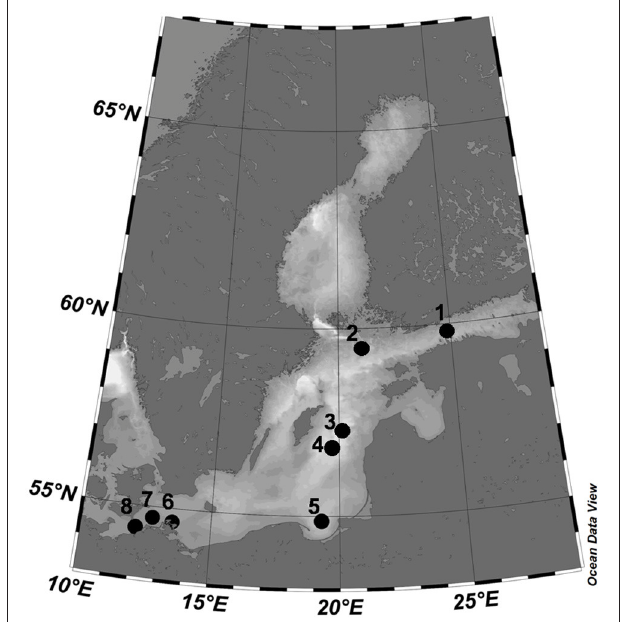
FIGURE 1 | Map of the Baltic Sea, showing the study area and the position of the eight sampling stations. According to the GPS coordinates, the station map was plotted using Ocean Data View ( Schlitzer,